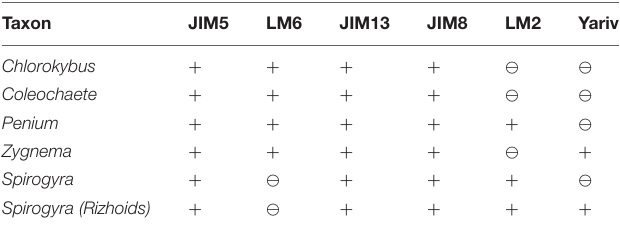
TABLE 1 | Immunofluorescence labeling of the